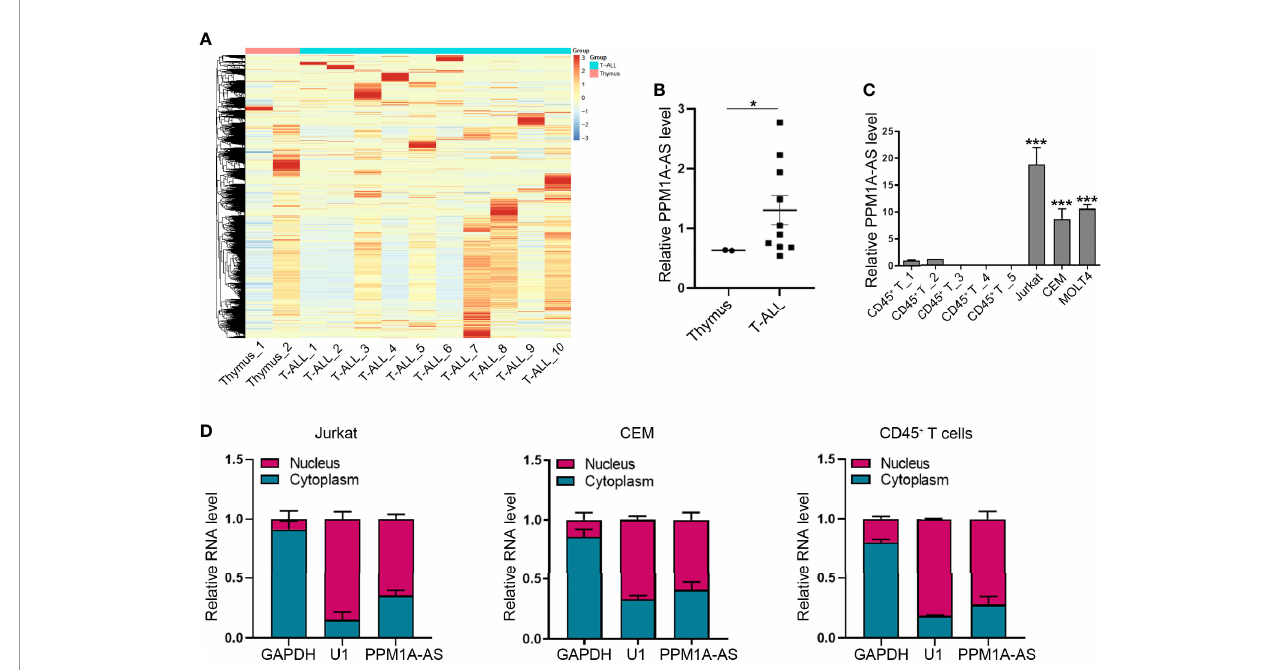
FIGURE 1 | LncRNA PPM1A-AS is up expressed in T-ALL. (A) The heatmap of lncRNA expression in 10 T-ALL samples and 2 healthy human whole thymus extracts. (B) The relative expression level of lncRNA PPM1A-AS in 10 T-ALL samples and 2 healthy human thymus extracts. (C) RT-qPCR analysis of lncRNA PPM1A-AS in T-ALL cell lines and healthy human CD45 + T cells. (D) The nuclear and cytoplasmic distribution of lncRNA PPM1A-AS in Jurkat, CEM and T cells extracted from healthy human. Mean ± SD. *P < 0.05. ***P <